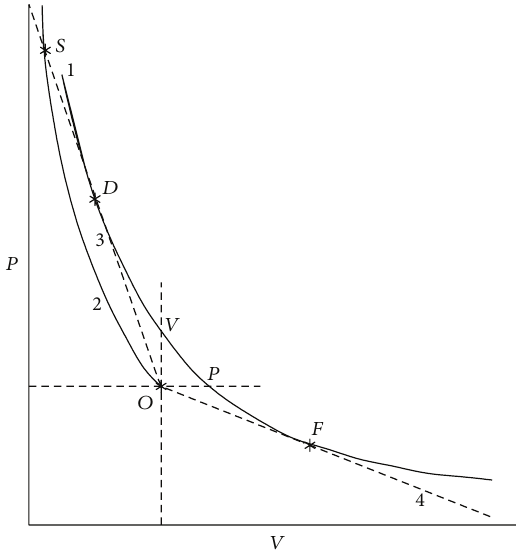
Figure 1: Typical ( 𝑃 - 𝑉 ), diagram of a combustible